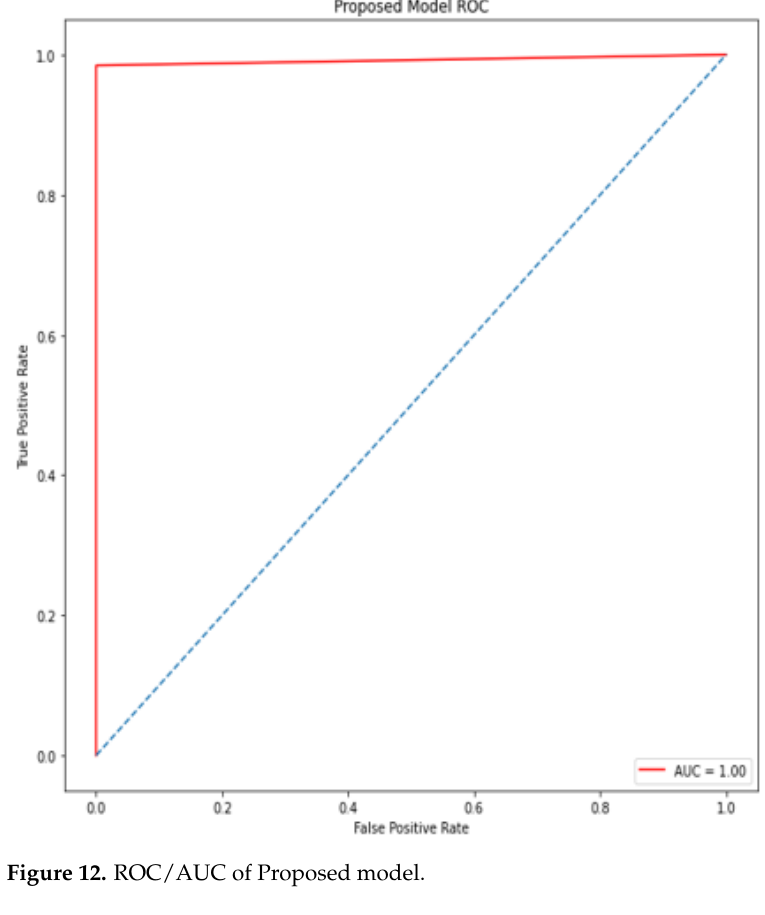
Figure 12. ROC/AUC of Proposed model.